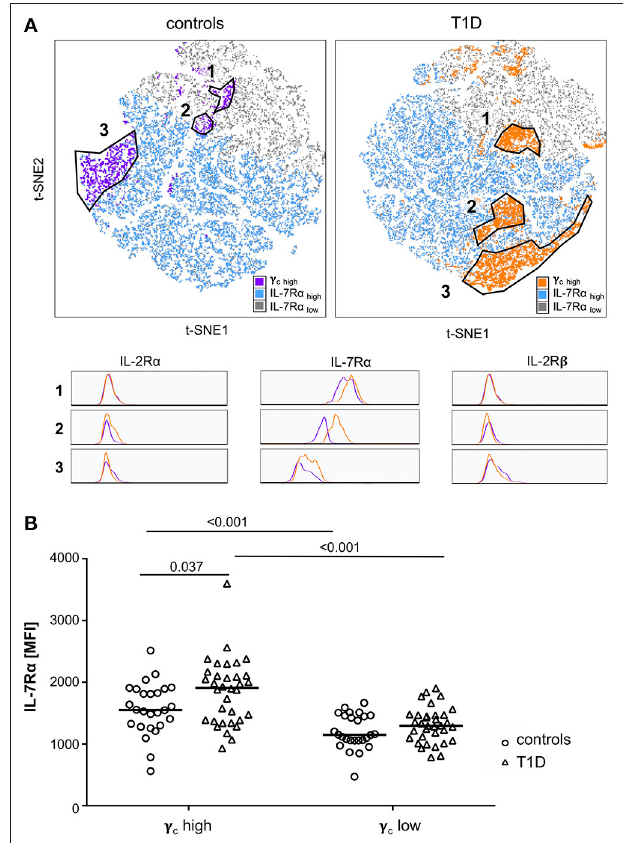
FIGURE 2 | Characterization of γ c high expressing memory T-cell populations. (A) Unbiased t-distributed Stochastic Neighbor Embedding (t-SNE) analysis of memory CD4 + T-cells (i.e., CD45RA low ) from healthy controls ( n = 20, left graph) and T1D patients ( n = 25, right graph). IL-7R α high cells (blue), IL-7R α low cells (gray), and γ c high cells (purple for controls; orange for T1D patients) are illustrated. γ c high populations (top10% mean fluorescence of all CD4 + /CD45RA low cells) of controls and patients were gated (populations 1, 2, and 3) and compared for the respective IL-2R α , IL-7R α and IL-2R β expression (histograms). (B) IL-7R α expression of γ c high and γ c low cells is shown for healthy controls ( n = 27, open circles) and T1D patients ( n = 34, open triangles). Median values of groups and statistically significant nominal p -values for the Mann-Whitney U-test (two-tailed) are